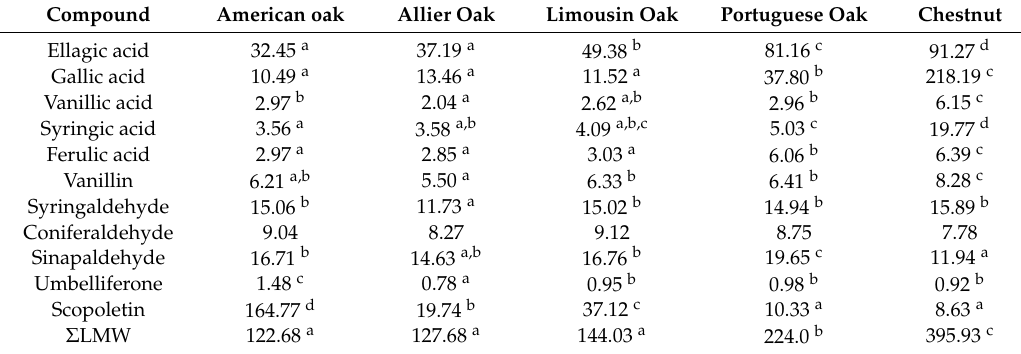
Table 3. Mean concentrations of low molecular weight compounds in wine spirits aged four years in different kinds of wood.